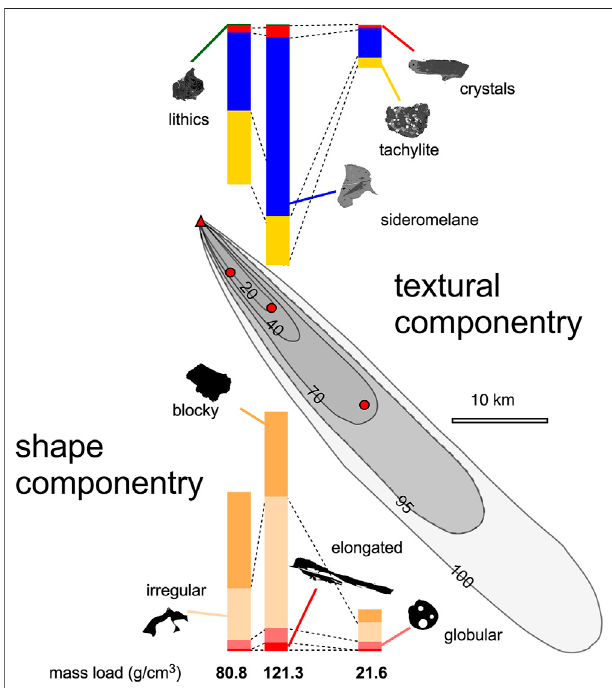
FIGURE 3 | Componentry of 125-180 μ m ash at the sampling locations (red points), in terms of both morphology and textural types. Componentry bars heights are normalized to relative mass load. Numbers indicate mass proportion of deposit within the